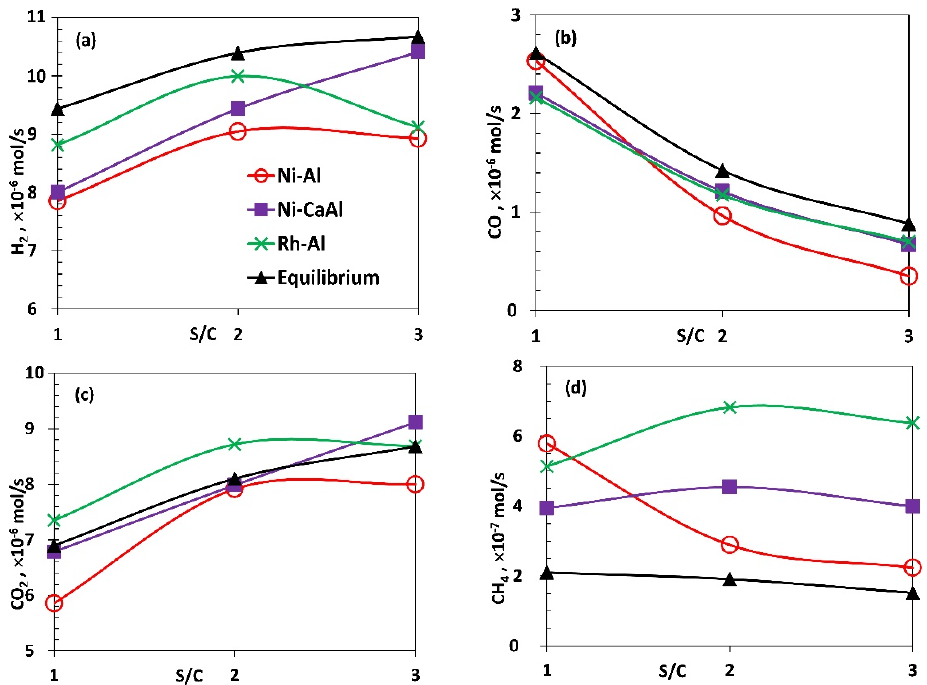
Figure 4. Average molar production rates ( a ) H 2 , ( b ) CO, ( c ) CO 2 and ( d ) CH 4 for the packed bed Ni and Rh catalysts compared to equilibrium. HAc flow, 1 mL/h with corresponding λ and temperature values of (0.340, 610 °C), (0.353, 570 °C) and (0.374, 545 °C) for S/C of 1, 2 and 3 respectively.